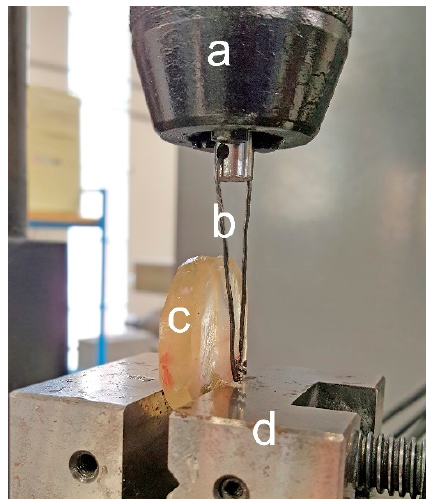
Figure 2. Schematic representation of the experimental setting for testing of shear bond strength. ( a ) Load cell; ( b ) metal loop that connects the bracket to the load cell; ( c ) embedded specimen secured to a vice ( d ).